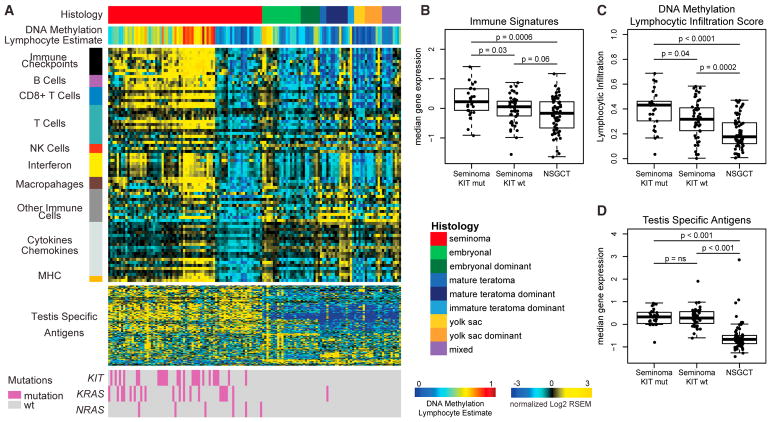
Immune Signatures Are High in Seminomas(A) Gene expression data (log2 median-centered RNA-seq by expectation maximization [RSEM] values) are displayed for 78 published gene expression signatures and ordered by immune category (left vertical bar). Tumors are ordered by histology and clustered by gene expression. Annotation tracks for DNA methylation lymphocyte infiltration score and mutation status are displayed.(B–D) Boxplots of immune features comparing seminoma KIT mutant, seminoma KIT WT, and NSGCTs. (B) Median expression of immune signatures, (C) DNA methylation lymphocytic infiltration scores, and (D) median cancer-testis-specific antigen gene expression. Boxplots display the median value, upper and lower quartiles, and the whiskers represent the interquartile range. Each dot represents the value of a single sample.See also Figure S6.